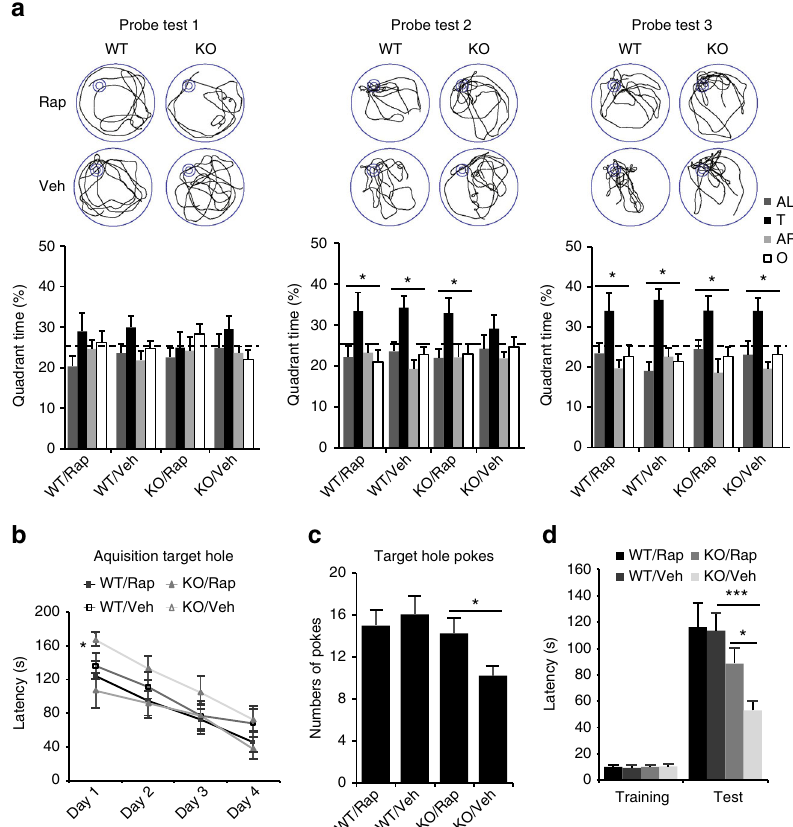
Fig. 5 Rapamycin treatment rescues behavioral de fi cits in Phf8 null mice. a Percentage time spent in each quadrant during the probe trials and representative swim trajectory of each group are evaluated in WT and Phf8 KO mice with vehicle or low-dose rapamycin treatment. (WT/Veh, n = 12; WT/ Rap, n = 11; KO/Veh, n = 12; KO/Rap, n = 11; paired two-tailed t -test, * p < 0.05). (Veh, vehicle injection; Rap, rapamycin treatment). b In Barnes maze, latency to reach the target hole is shown during training days. (WT/Rap, n = 11; WT/Veh, n = 12; KO/Rap, n = 10; KO/Veh, n = 10; unpaired two-tailed t - test, * p < 0.05). c Probe trial on day 5 is used to assess spatial memory retention. Number of pokes in target hole during the probe trial (90 s) are calculated and averaged (WT/Rap, n = 11; WT/Veh, n = 12; KO/Rap, n = 10; KO/Veh, n = 10; unpaired two-tailed t -test, * p < 0.05). d Phf8 KO mice show de fi cit in the passive avoidance test and rapamycin treatment rescues the de fi cit. The bars indicate the mean latencies to enter the dark chamber on the training day (left) and 24 h later on the retention day (right). (WT/Rap, n = 9; WT/Veh, n = 13; KO/Rap, n = 9; KO/Veh, n = 10; unpaired two-tailed t-test, * p < 0.05, *** p <